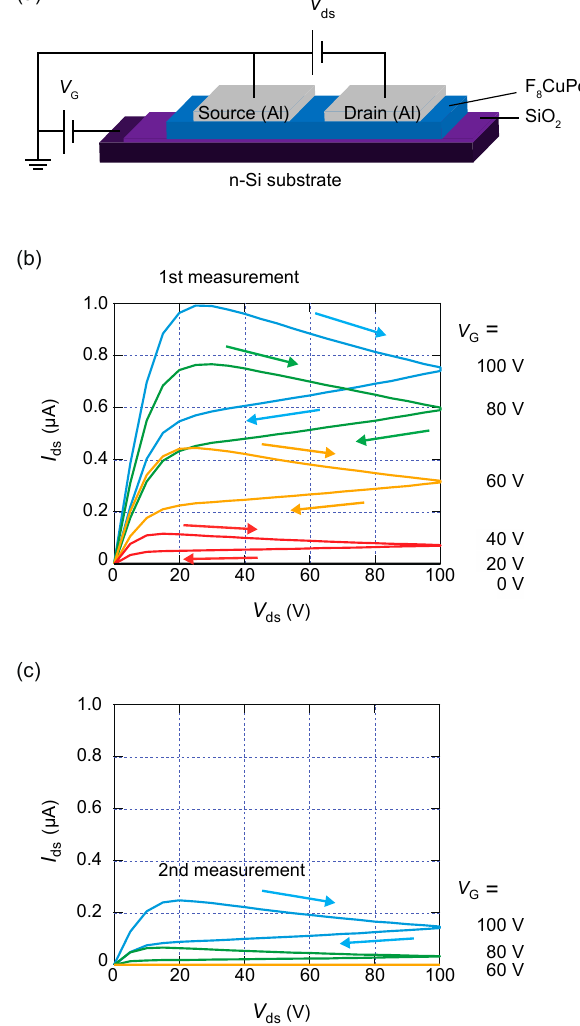
Figure 4. ( a ) Schematic of an F 8 CuPc film transistor; ( b ) current-voltage characteristics of the F 8 CuPc film transistor measured in air; and ( c ) those obtained from repeated measurements; these were performed immediately after the first.